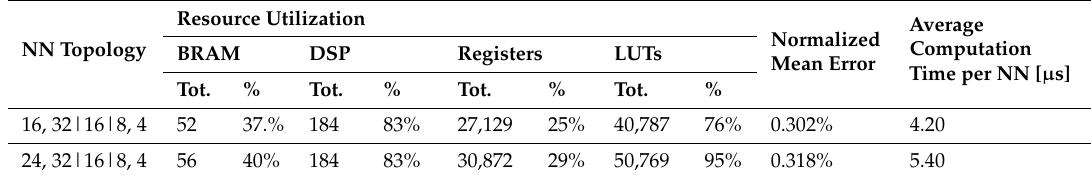
Table 8. NN inference on FPGA: implemented solution results for a batch of 1024 NNs {16, 32|16|8,